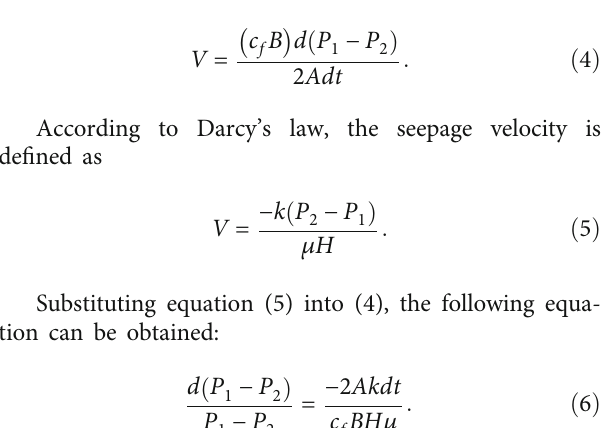
Figure 9: Principle of the transient method.